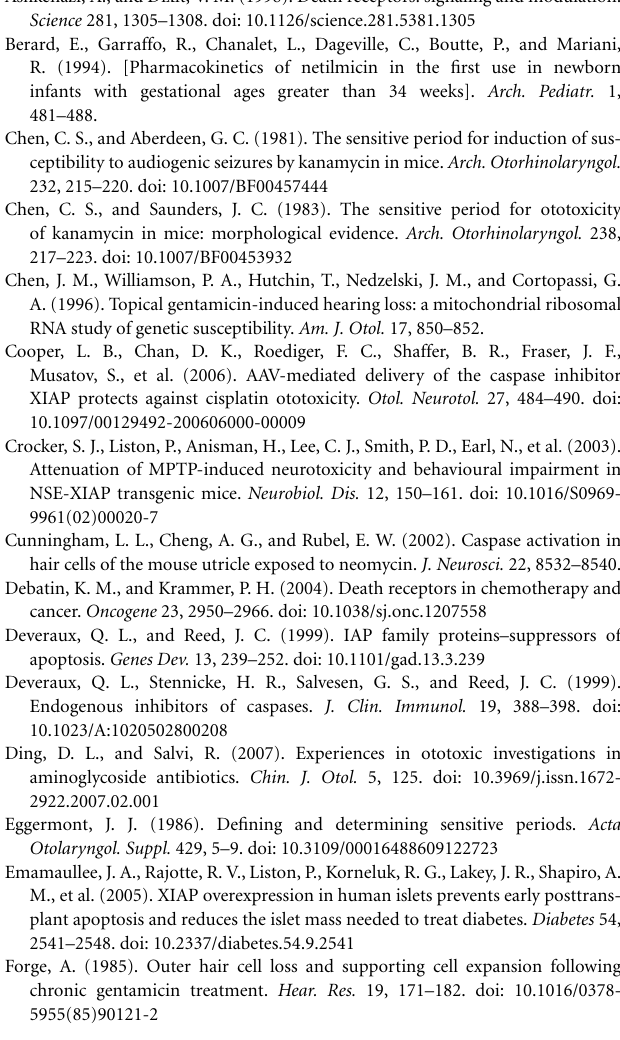
Figure S1 | Caspase-3 expression in WT mice after neomycin treatment. (A) Representative confocal images of myo7a immunofluorescence in cochlear whole mounts of WT mice sacrificed at 1, 3, 5, or 7 days after the last injection of neomycin or saline (control). Neomycin or saline was injected between P1 and P7 (Group 1), P8 and P14 (Group 2), P15 and P21 (Group 3), or P60 and P66 (Group 4). (B) Myo7a + HC quantification in WT mice treated with neomycin or saline (control) between P1 and P7 (Group 1), P8 and P14 (Group 2), P15 and P21 (Group 3), or P60 and P66 (Group 4) and sacrificed at 1, 3, 5, or 7 days after the last injection of neomycin or saline. ∗∗ p < 0 . 01 vs. control and # p < 0 . 05, ## p < 0 . 01 vs. Group 2, n = 3. Scale bar in A = 10 μ